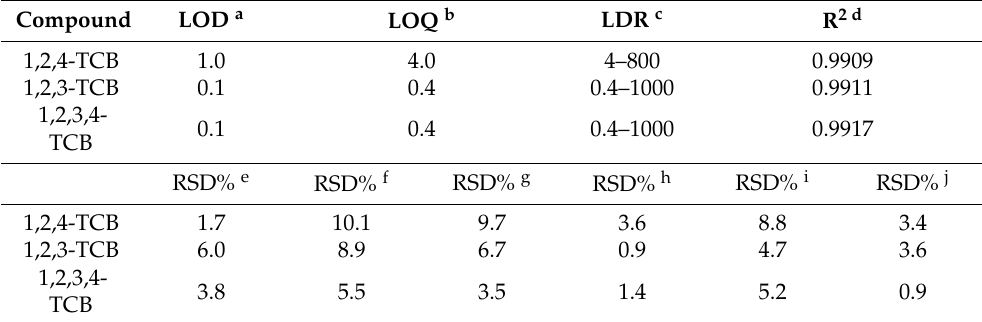
Table 1. Analytical figures of merit obtained for the selected CB mixtures using the HS-SPME method based on PU–PSU/calix[4]arene coupled with